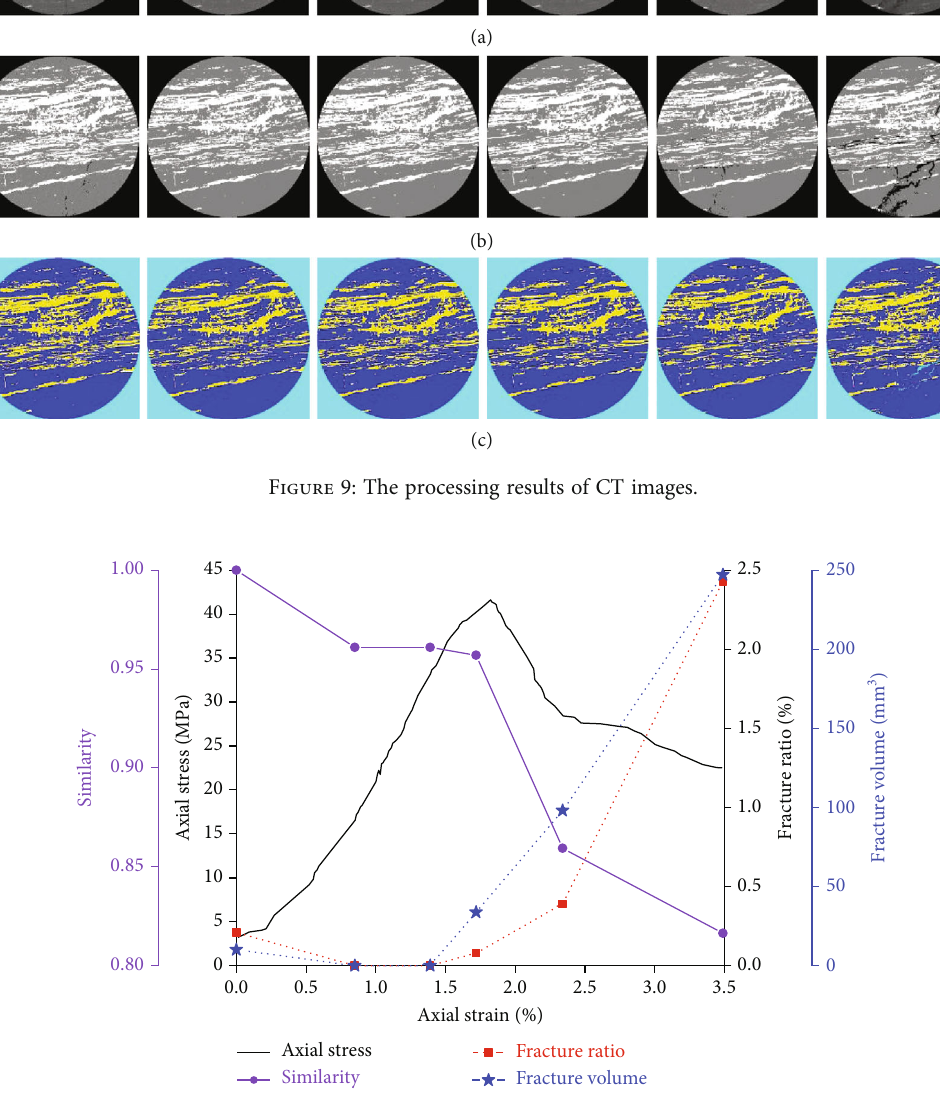
Figure 10: The fracture evolution trend of the coal